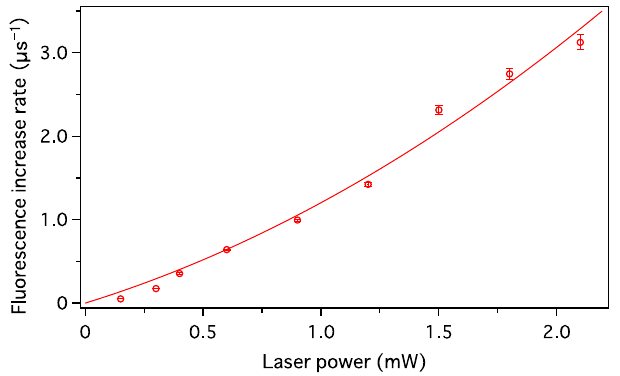
FIG. 11. Plot of laser power dependence of fluorescence increase